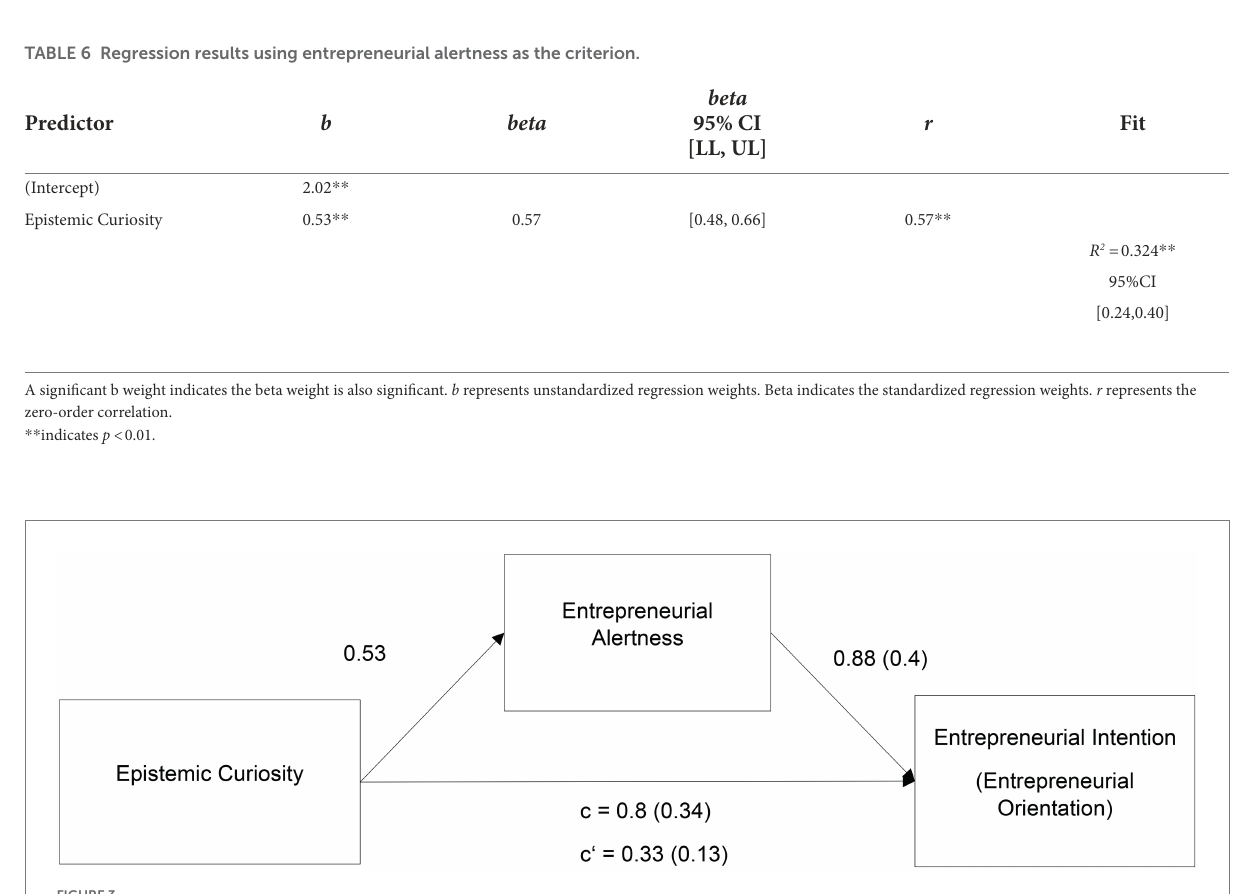
FIGURE 3 Mediational model for the prediction of entrepreneurial intention and orientation. Coefficients written on the paths are direct effects. “c” is the effect of epistemic curiosity on the criterion with the effect of alertness included. Values in brackets are direct effects on the criterion entrepreneurial orientation,